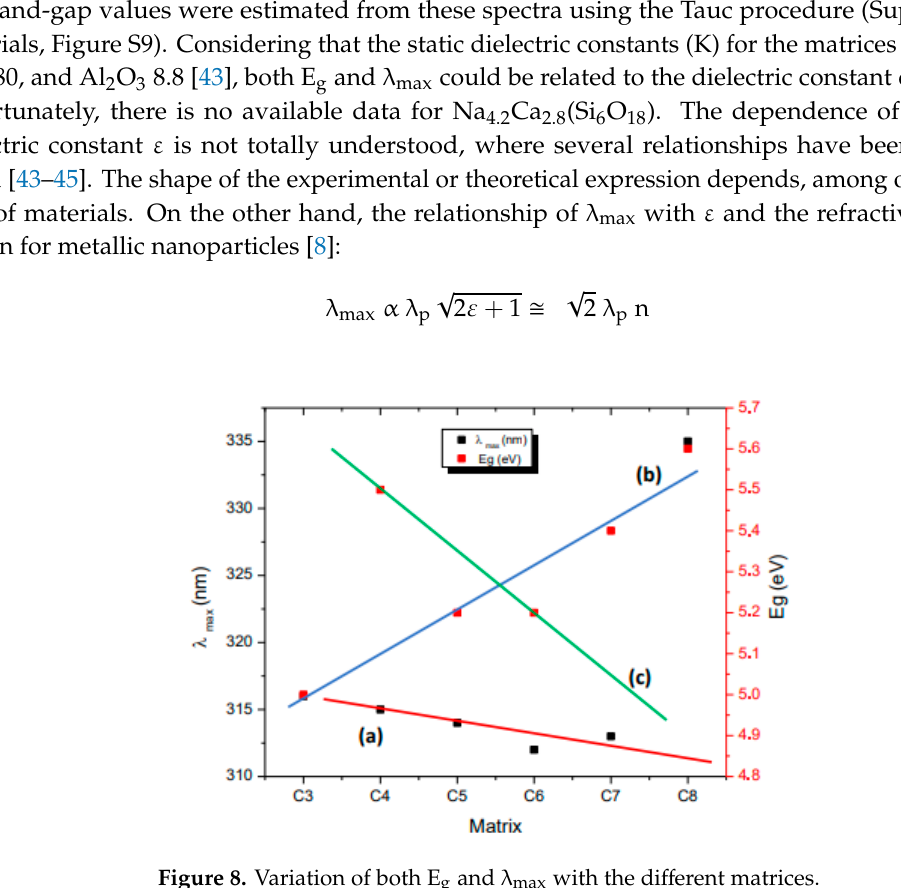
Figure 7. Photocatalytic behavior of NiO embedded in several matrices.